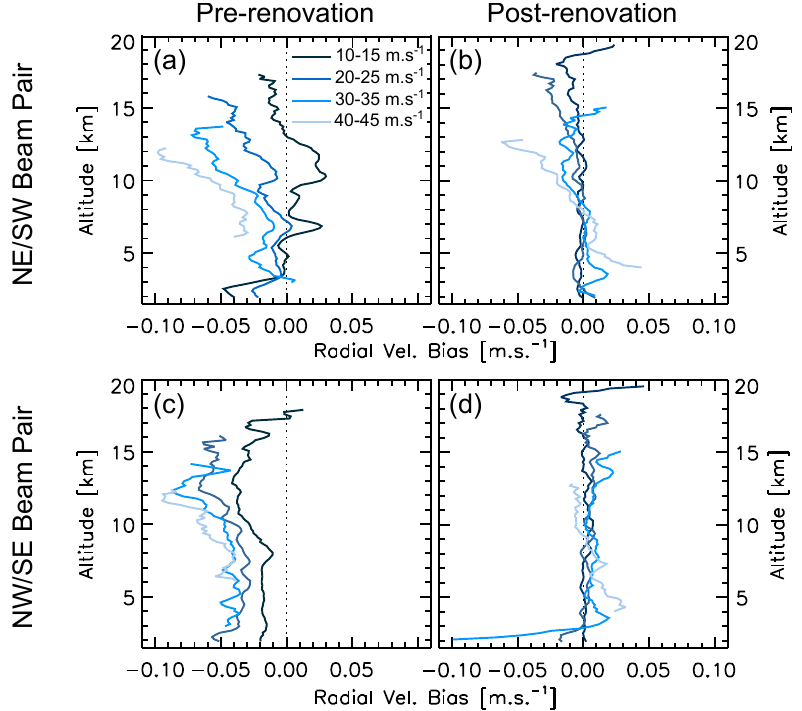
Figure 2. Vertical velocity bias at different wind speeds before and after the renovation. Biases are derived from comparison of vertical beam vertical velocities and the difference of complementary beam radial velocities (Eq. 6). Different shaded curves correspond to different horizontal wind speeds. The curves comprise all valid winds where the mean wind direction was within 45 ◦ of the NE beam azimuth (27.5 ◦ ), during 2010 (pre-renovation) and 2012 (post-renovation). Negative biases correspond to an underestimate of vertical velocity by the complementary beam pair. (a) Pre-renovation biases from the NE–SW beam pair. (b) As (a) but post-renovation. (c) As (a) but for NW–SE beam pair. (d) As (b) but for NW–SE beam